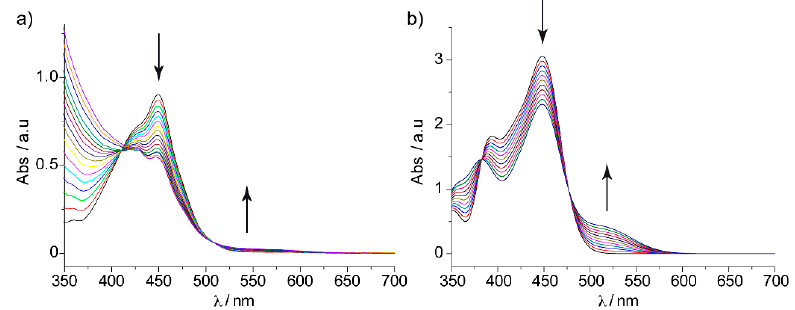
Figure 18. ( a ) Experimental UV–Vis spectra, as obtained during the titration of truxTTF (1.7 × 10 − 4 M) with C 30 H 12 (0.8 × 10 − 3 M) in CHCl 3 at room temperature; ( b ) TD-DFT simulation of the absorption spectrum of truxTTF as the ratio of truxTTF•C 30 H 12 increases from 0 to 100% (B3LYP/cc-pVDZ calculations including CHCl 3 as solvent for structure A4 ). Adapted with permission from [18]. Copyright 2014 WILEY-VCH Verlag GmbH & Co.